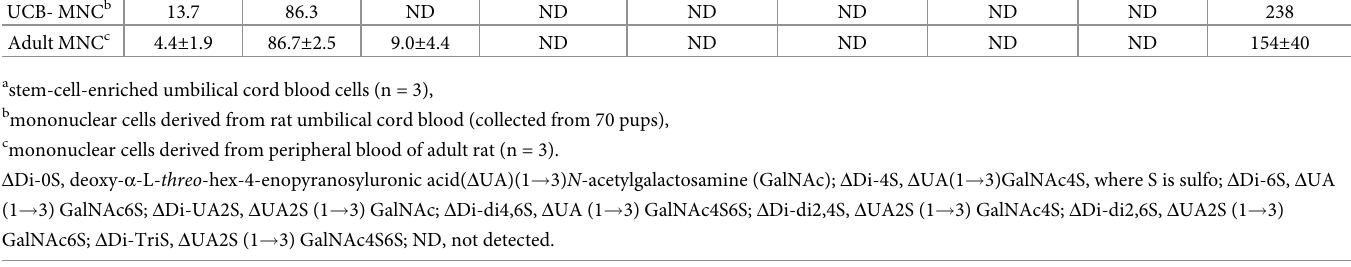
Table 2. Disaccharide composition of CS/DS in GAG from UCBCs and MNCs. Sample Unsaturated disaccharide units